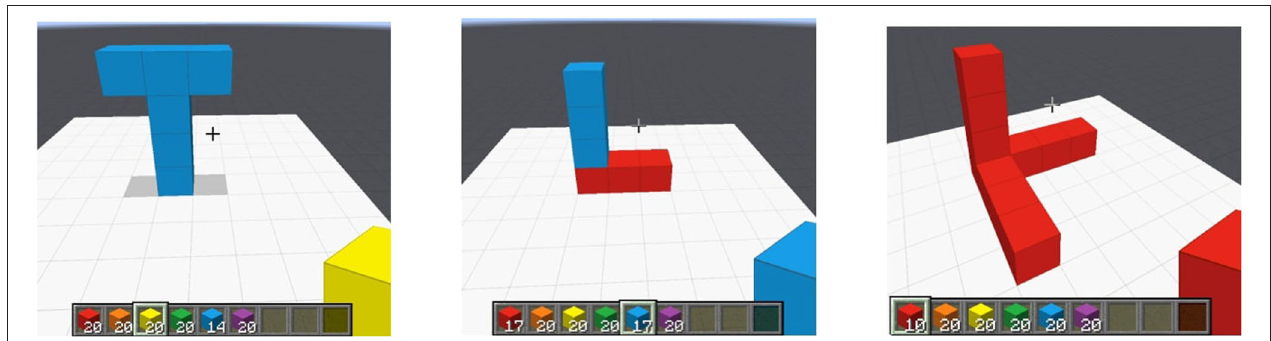
FIGURE 5 | Instances of spatial concepts in Minecraft. (Left) Upright Tee, (Middle) Upright L, (Right) Orthogonal overlapping Ls .